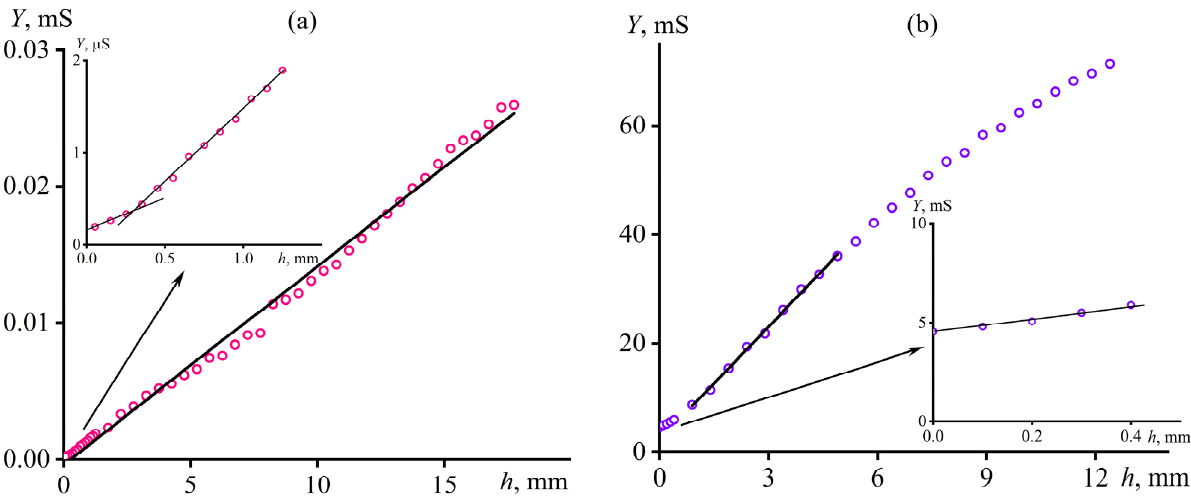
Figure 7. Dependences of admittance of a cell with saturated NaCl solution on the immersion depth of carbon electrodes: elementary filaments ( a ) and multifilament bundles ( b ). The insets show enlarged sections of the same curves in the region of small immersion depths of the electrodes. AC frequency: 120 Hz.